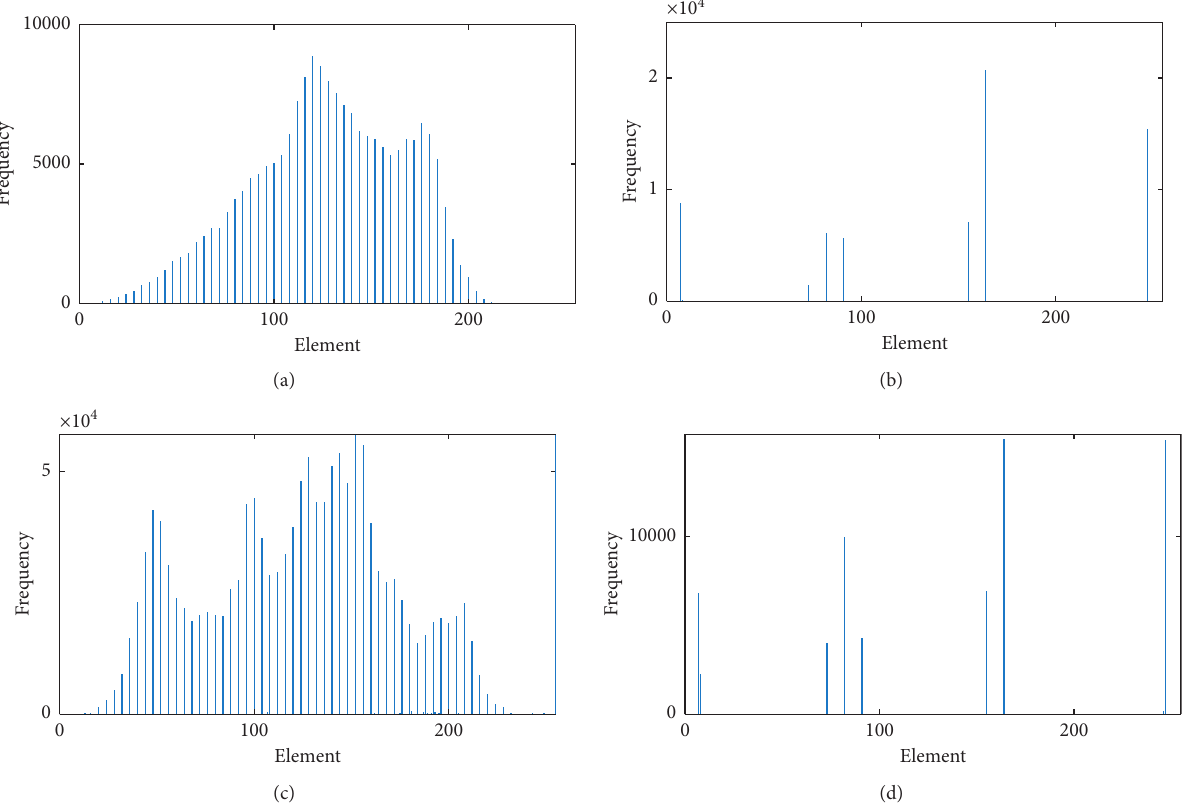
Figure 13: (a) Histogram of the original image Lena. (b) Histogram of the encrypted image Lena. (c) Histogram of the original image Baboon. (d) Histogram of the encrypted image